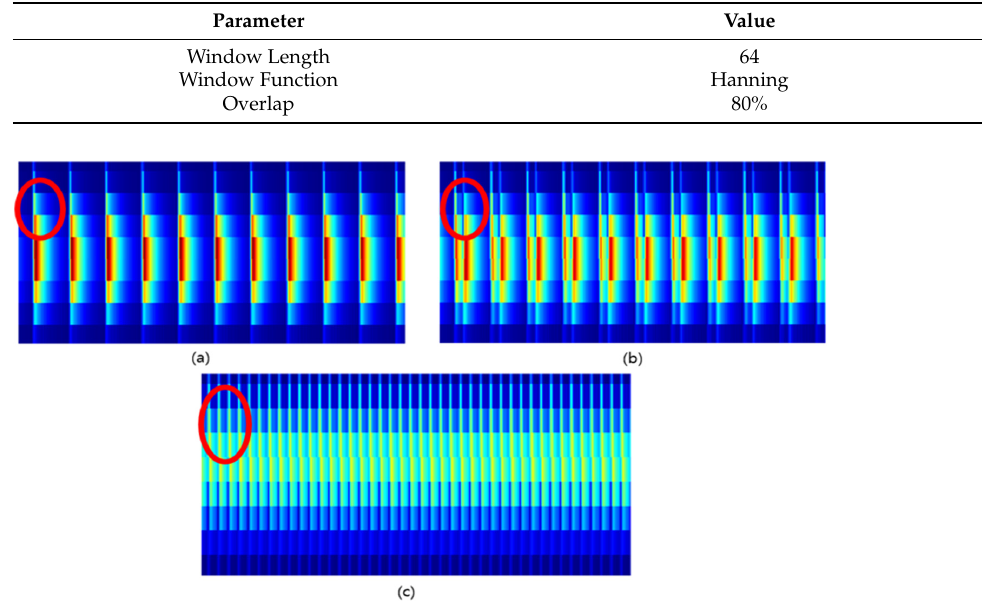
Table 5. Parameter values of STFT.